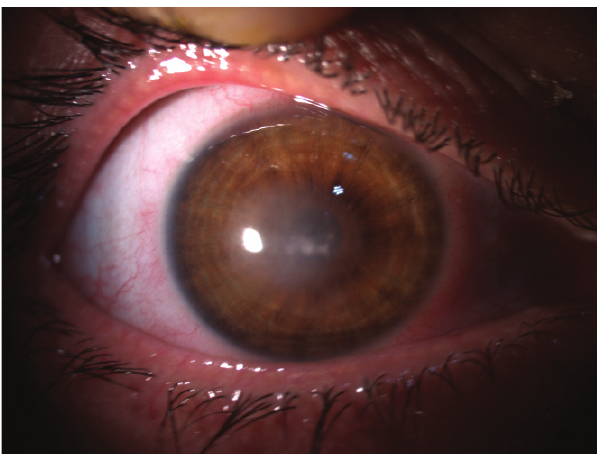
Figure 2 - The infection resolved, but residual central stromal opacification remained in the right